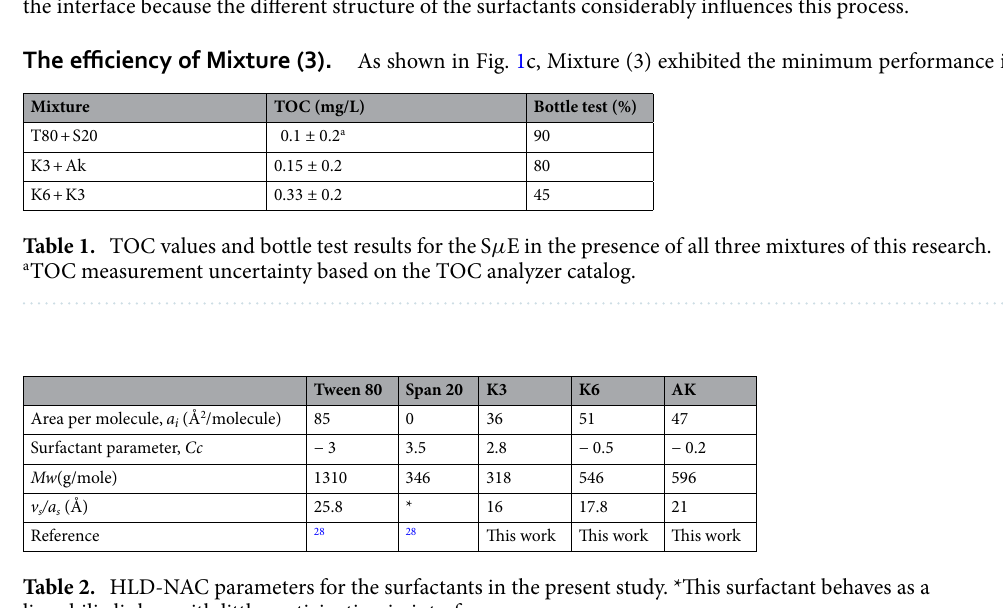
Table 2. HLD-NAC parameters for the surfactants in the present study. *This surfactant behaves as a lipophilic linker, with little participation in interface.